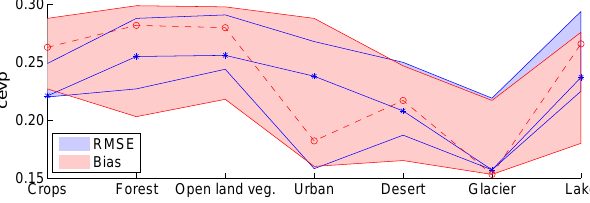
Figure 7. Coefficient of potential evapotranspiration (cevp) param- eter as identified (the range is derived from the 100 parameter sets that perform best, and the optimum set) for different objective functions (RMSE and Bias) and land-use type. Lines with markers present the optimum parameter values for different objective func-